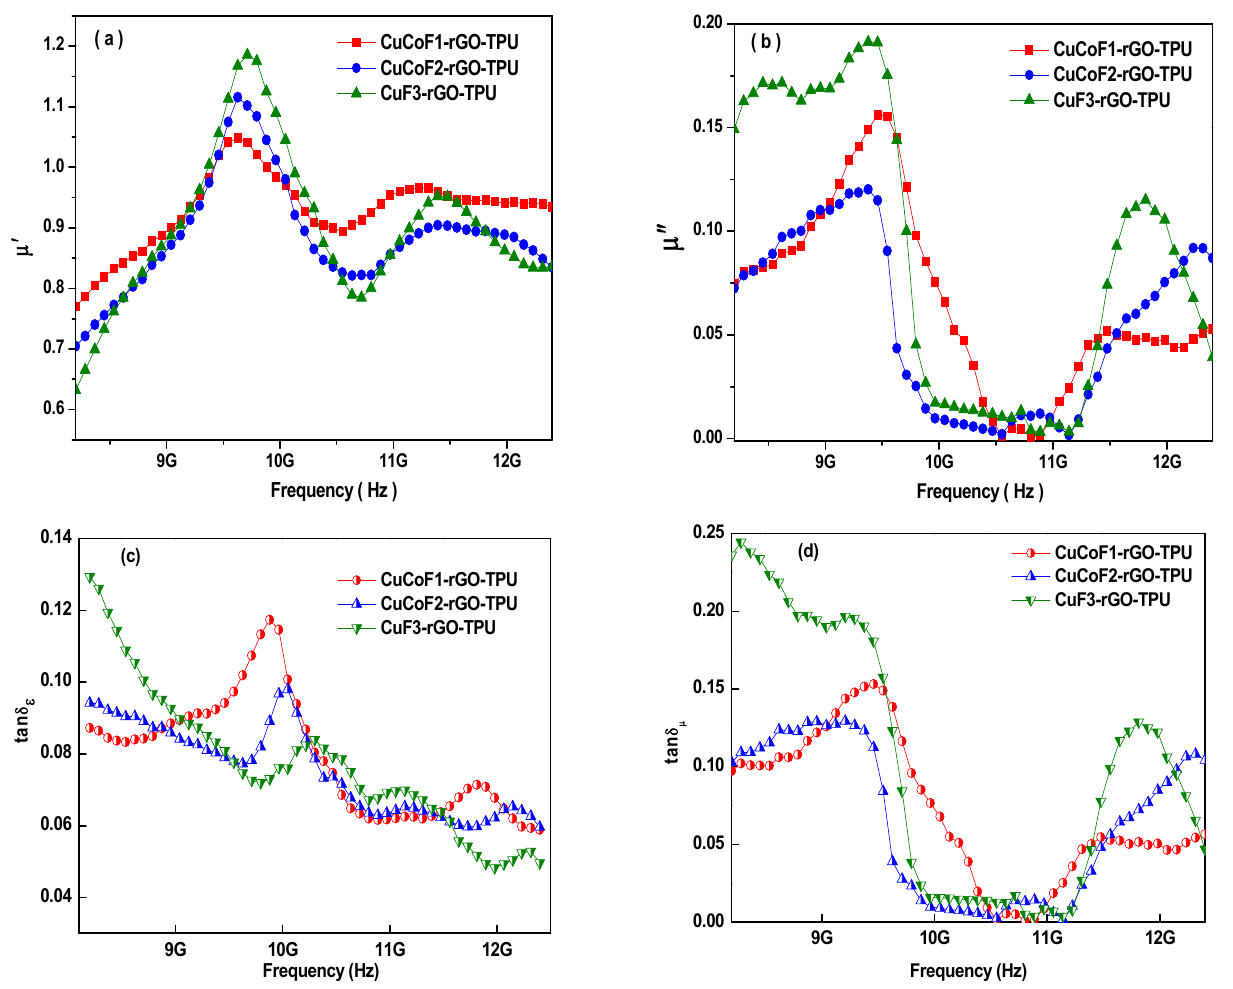
Figure 9. Variation of ( a ) the real part ( μ′ ) of permeability, ( b ) the imaginary part ( μ″ ) of permeability, ( c ) dielectric loss, tan δ ε ( d ) magnetic loss, tan δ μ with change in frequency for CuCoF1, CuCoF2, and CuF3 nanoparticles based nanocomposites along with rGO in TPU